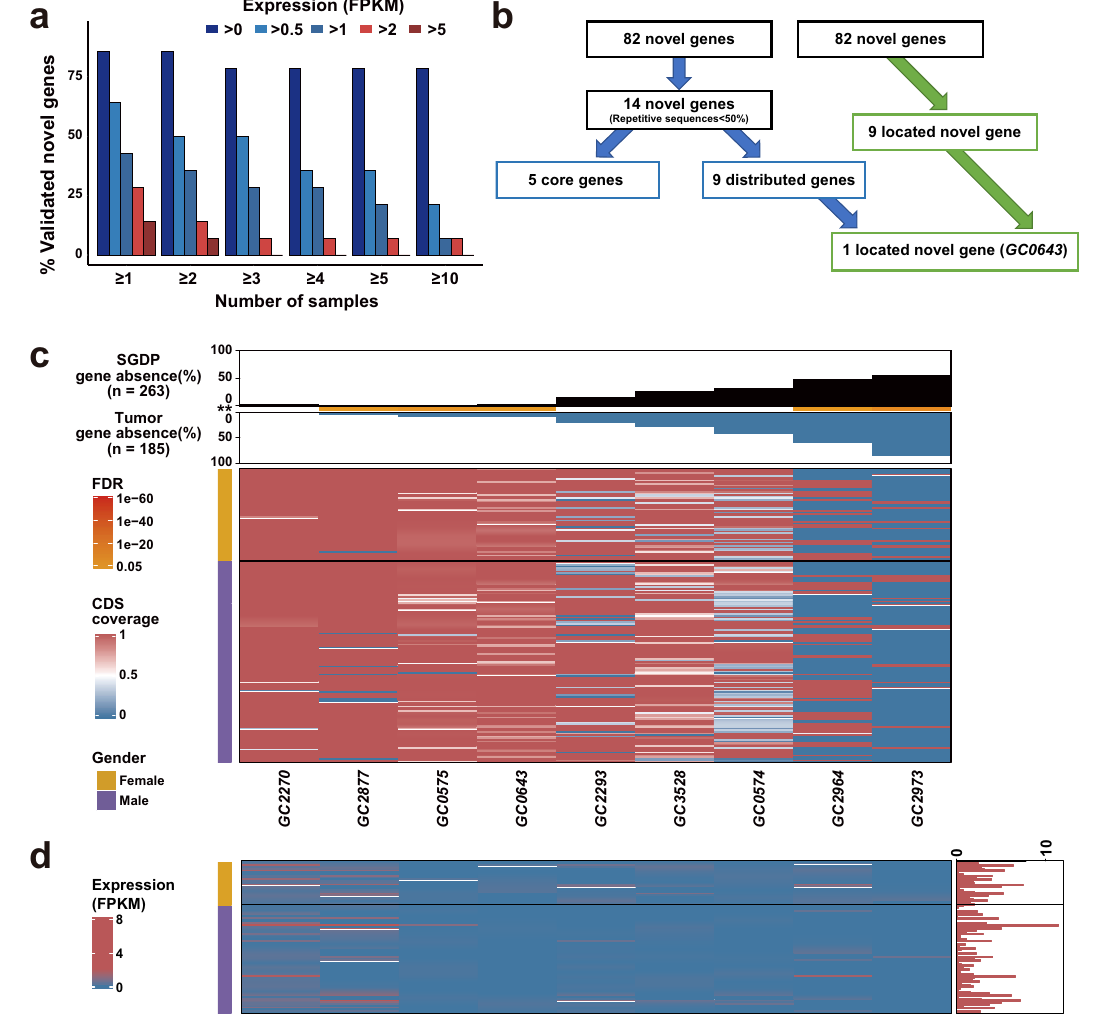
Fig. 4 | The PAVs feature of nine predicted new genes in gastric cancer using GCPAN as the reference. a The mRNA transcription (>1 FKPM) in 6 out of 14 predicted new genes was con fi rmed in at least one cancer sample. b Illustration of the alignment tree of 82 predicted new genes. c PAVs pro fi le of predicted new genes. The top bar plot shows the different frequencies of absence variation in SGDP dataset (black bar) and gastric cancer group (blue bar). The orange line between the two cohorts indicates the signi fi cant difference of absence variation